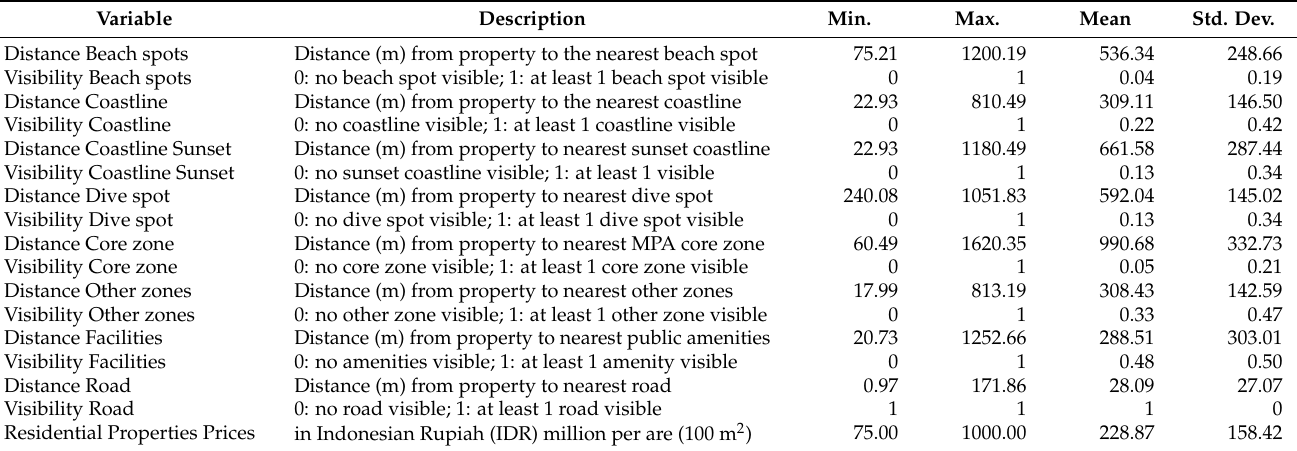
Table 1. Statistical summary for model HR1 of residential property prices in Gili Matra Islands.